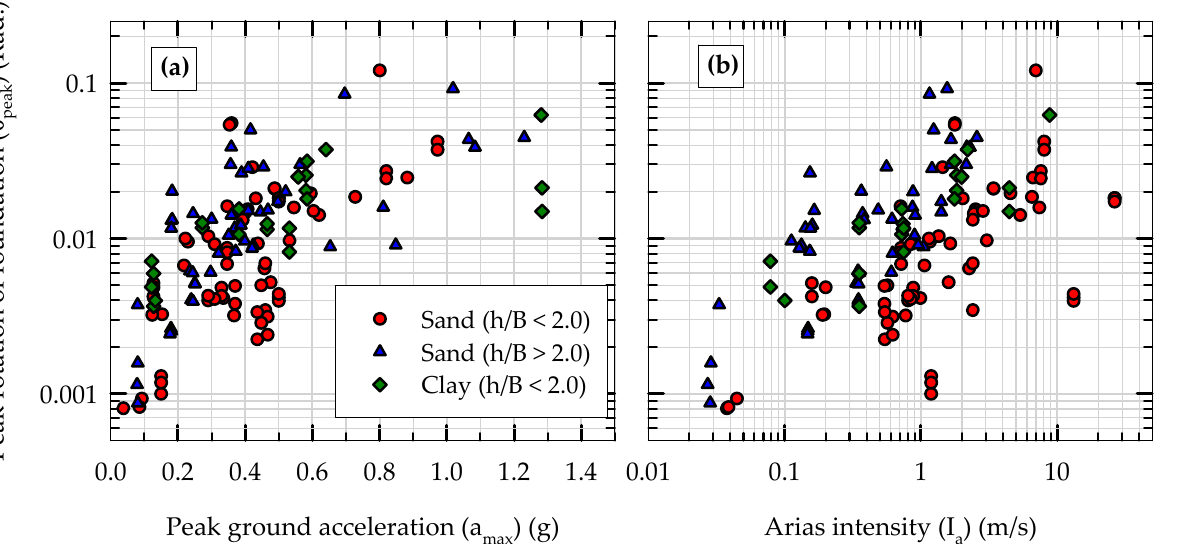
Figure 2. Variation of peak rotation of rocking foundation with ( a ) peak ground acceleration and ( b ) Arias intensity of ground motion for rocking structure–foundation system with different slenderness ratios (h/B) (Note: (i) data obtained from 140 centrifuge and shaking table experiments, (ii) (h/B) > 1.0 for all experiments, and (iii) both figures share the same legend).